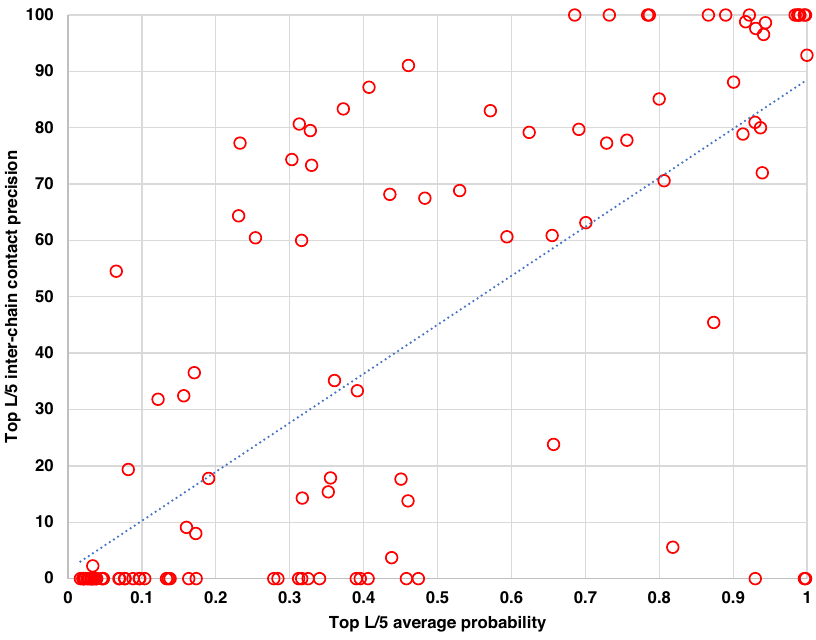
Fig. 4 | The plot of inter-chain contact prediction precision against average contact probability. The y-axis is the precision of top L/5 inter-chain contact predictions made by CDPred for a target, and the x-axis is the average probability